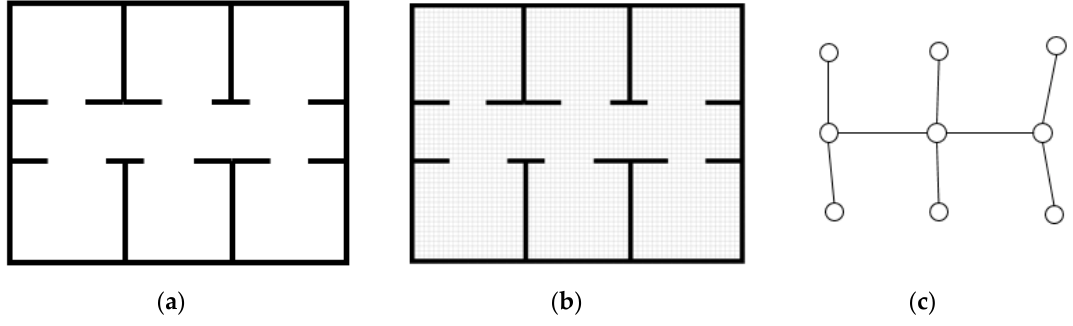
Figure 1. An example of a grid and topological map. The grid map maintains all the areas on a cell-by-cell basis. The topological map maintains the map through nodes and edges. ( a ) Environment, ( b ) Grid map, ( c ) Topological map.